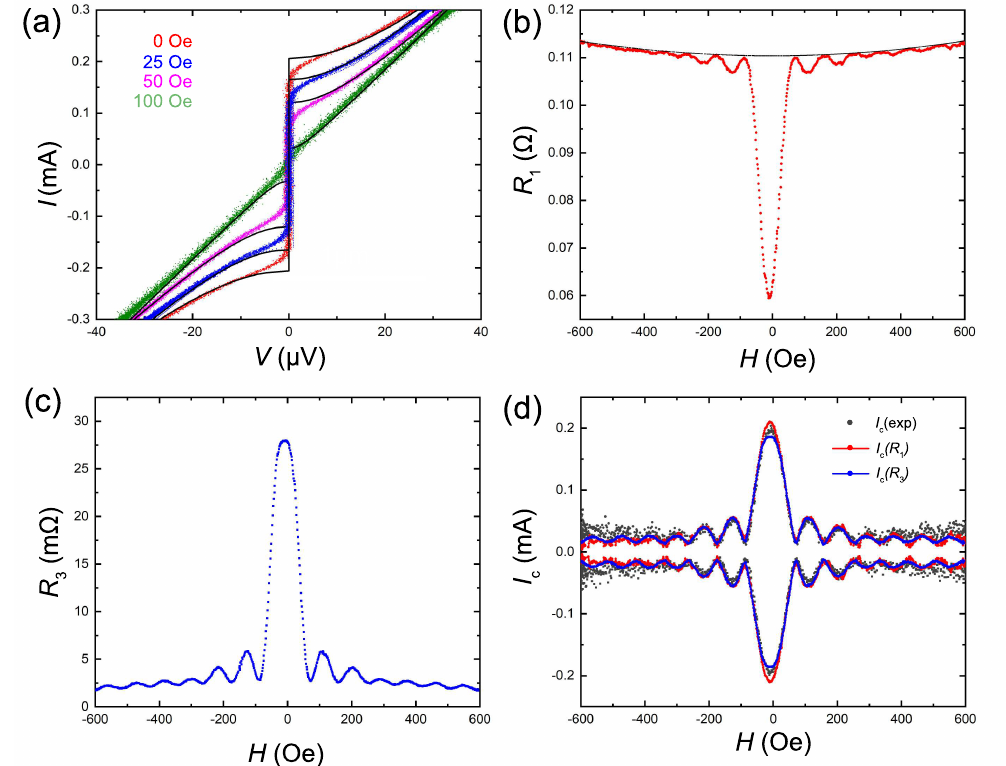
Figure 2. ( a ) I – V characteristics of the Nb–PtNi–Nb junction at T = 4.47 K, at different in-plane magnetic fields. Black lines represent RSJ fits. ( b , c ) Field modulation of the first ( b ) and the third ( c ) lock-in harmonics of resistance for this junction. ( d ) Magnetic field modulation of critical currents measured experimentally, I c (exp), (black symbols) and reconstructed from the first (red) and third (blue line) lock-in